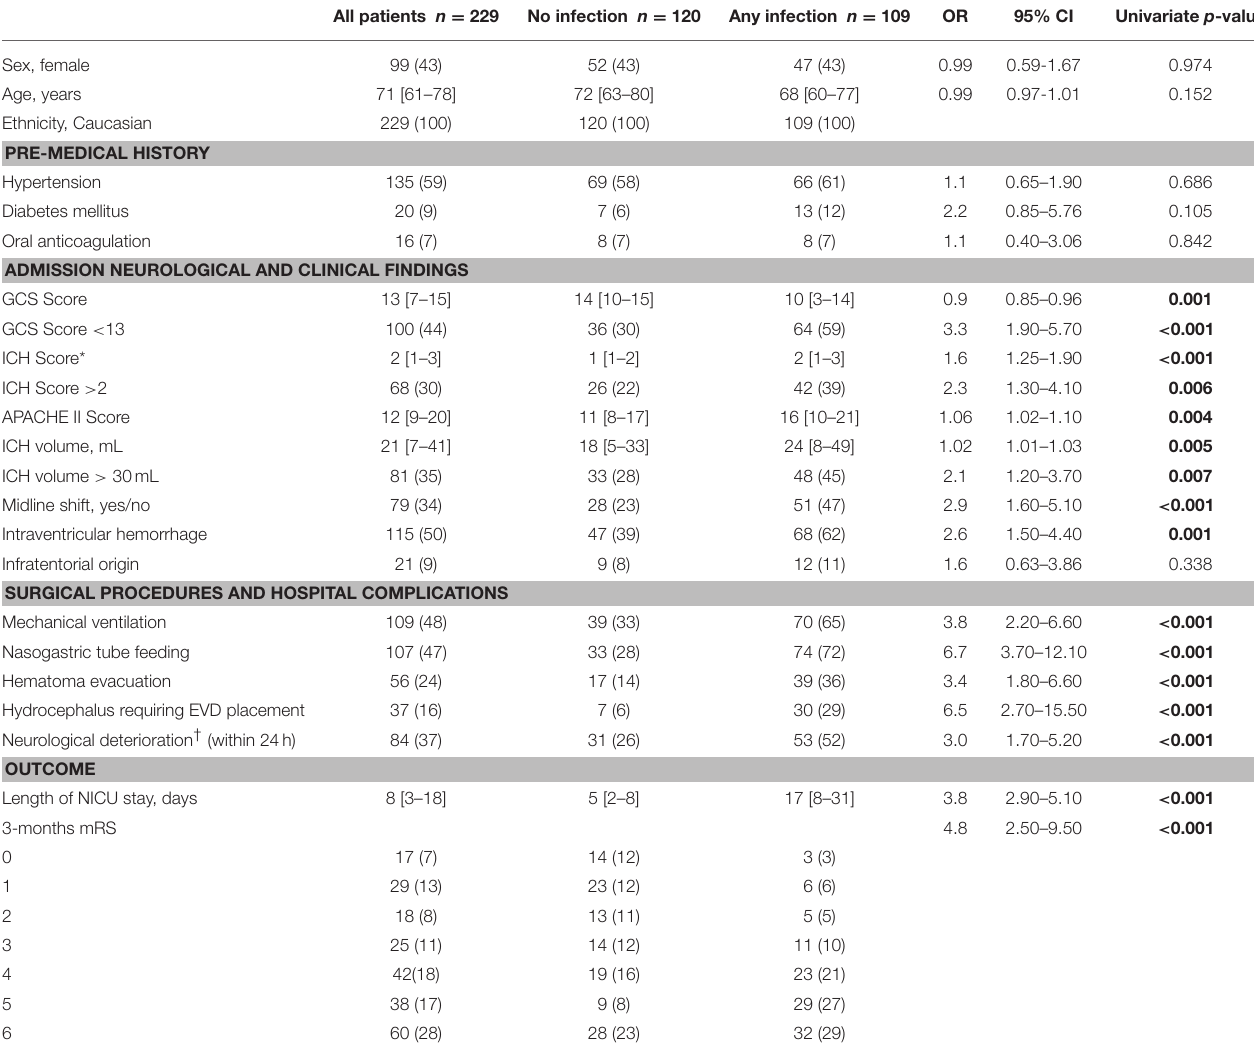
TABLE 1 | Baseline characteristics, complications, and outcome. All patients n = 229 No infection n = 120 Any infection n = 109 OR 95% CI Univariate p